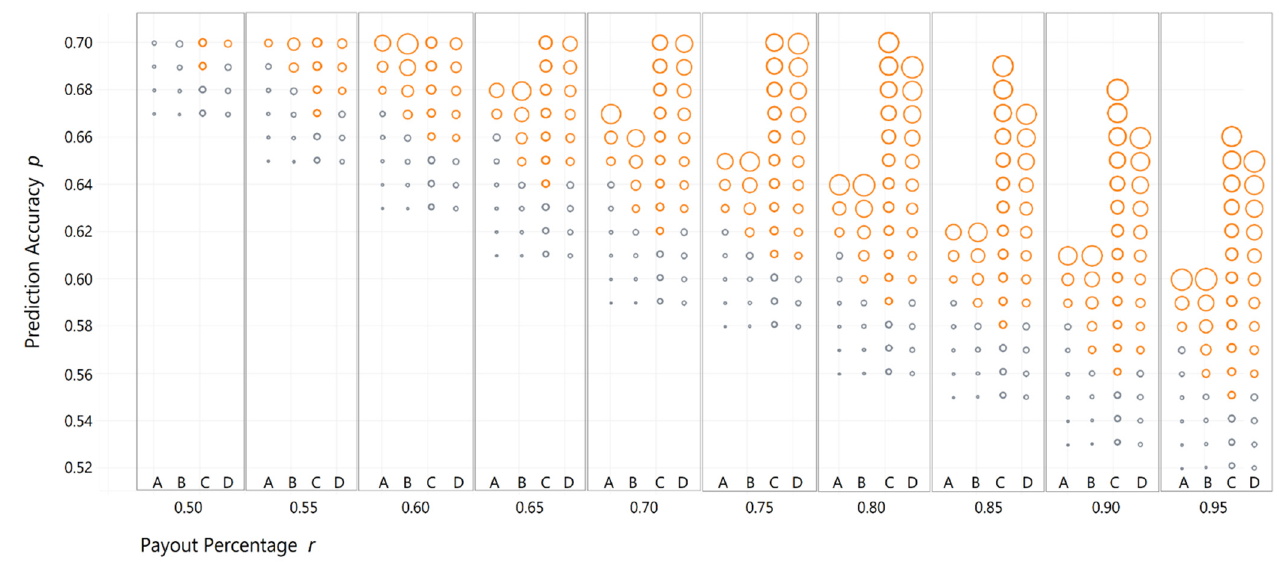
Figure 4. Relation between binary option parameters (cid:4666)𝑝, 𝑟(cid:4667) and return on investment ( 𝑟𝑜𝑖 ) across all four strategies.